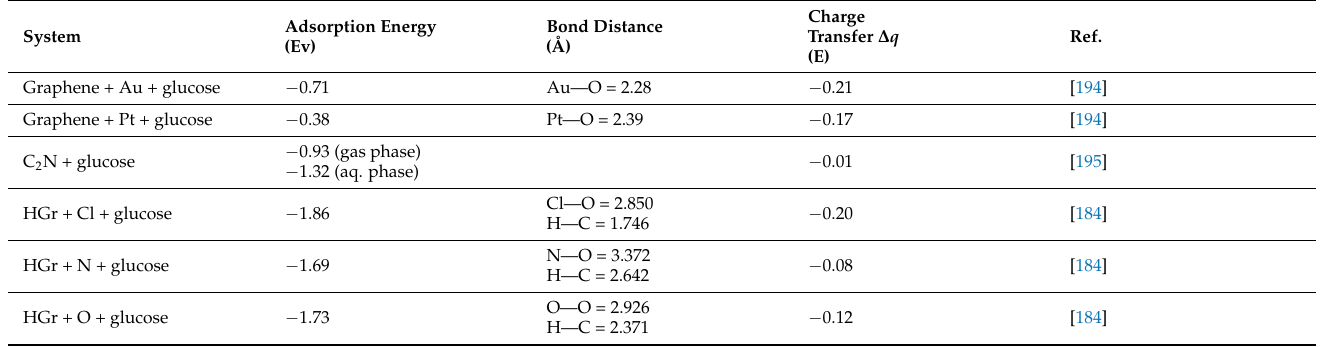
Figure 14 . DFT optimised structures of glucose interaction with ( a ) Ag- ( b )Au-doped graphene ( c ) Pt/graphene heterostructure. Reprinted with permission from Ref. [194], 2020, Elsevier. Charge density difference plots of glucose adsorbed ( d ) N- ( e ) O- and ( f ) Cl- doped hydrogenated graphene (HGr). Yellow and blue surfaces represent the charge density reduction and gain, respectively, with an isovalue of 0.0075 e Å − 3 . Reprinted from Ref. [184]. Table 5. Binding energy, bond distances, and charge transfer of various glucose adsorption